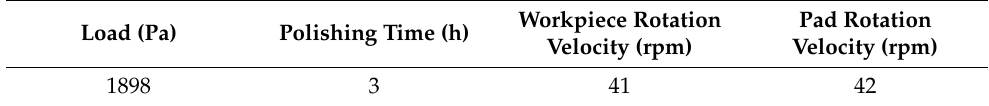
Figure 10. Pitch-button blocked workpieces. Table 1. Polishing parameters of the polishing experiments.